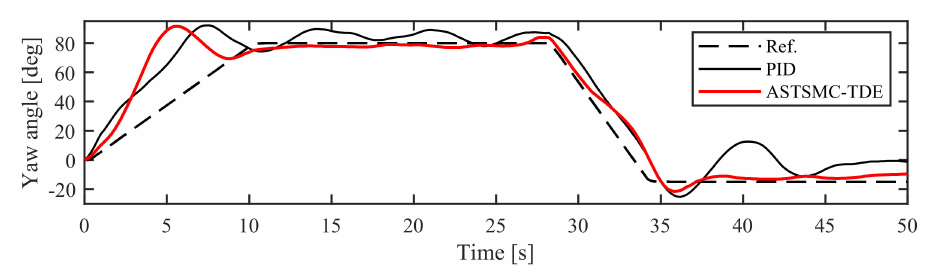
Figure 26. The experimental yaw angle trajectory tracking in AM mode.